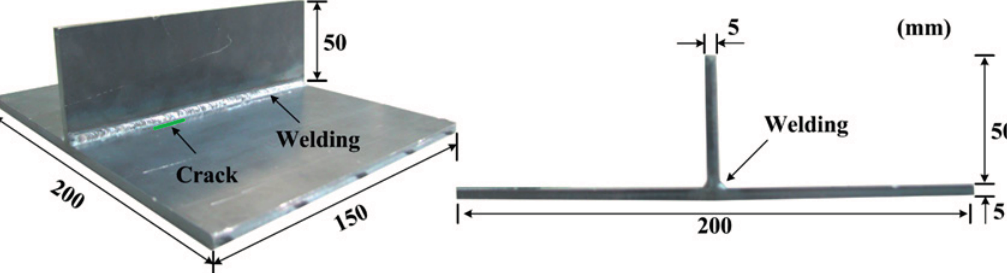
Figure 1. A vertically stiffened steel specimen with a